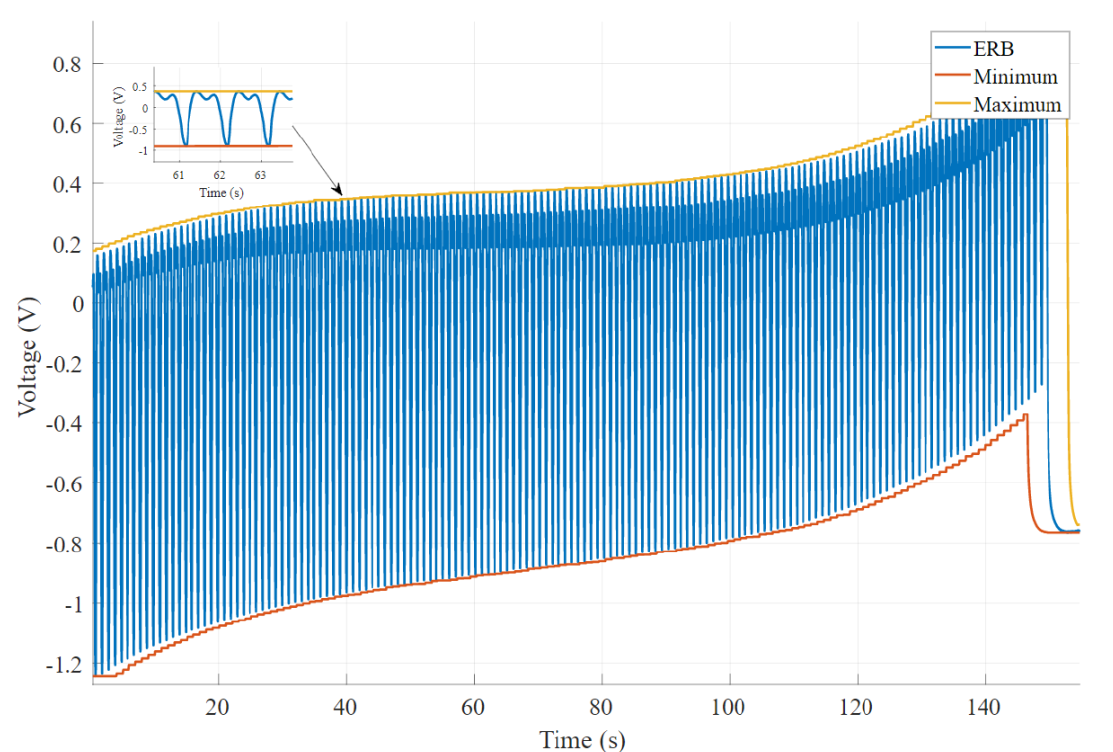
Figure 8. An example output of the band voltage where signal amplitude decreases significantly over time. The output also shows a high baseline change.